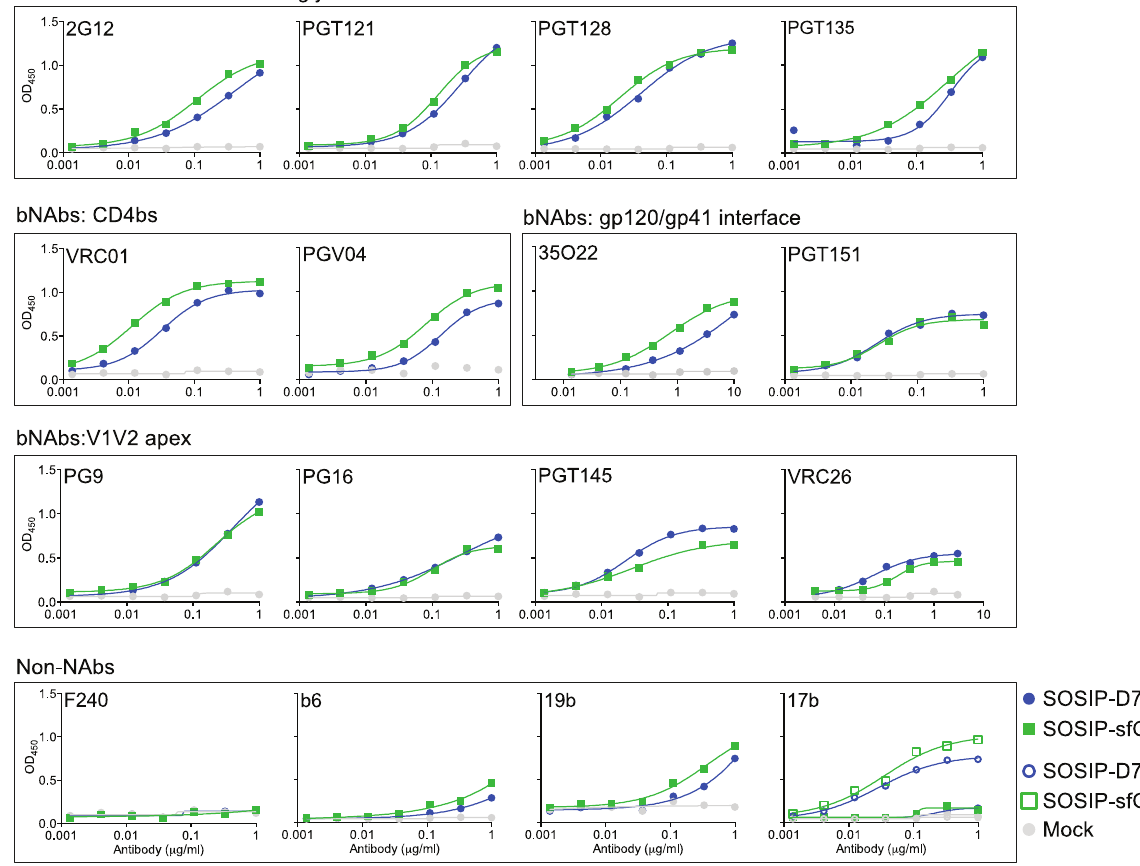
Figure 4. Antigenicity of SOSIP-sfGFP determined by ELISA. Representative ELISA binding curves of PGT145-purified SOSIP and SOSIP-sfGFP to a panel of bNAbs and non-NAbs specific for different epitope clusters on the HIV-1 Env